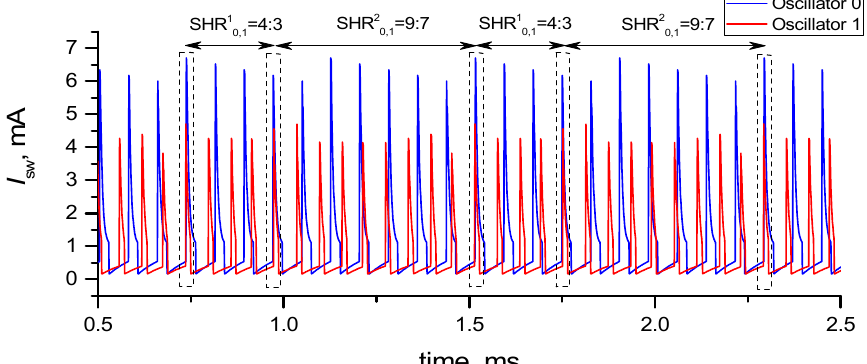
Figure 1. An example of a chimeric synchronization of oscillators with an alternating synchronization pattern of current pulses in an oscillogram. The dotted line marks synchronization moments of individual pulses. I sw is the oscillator current.